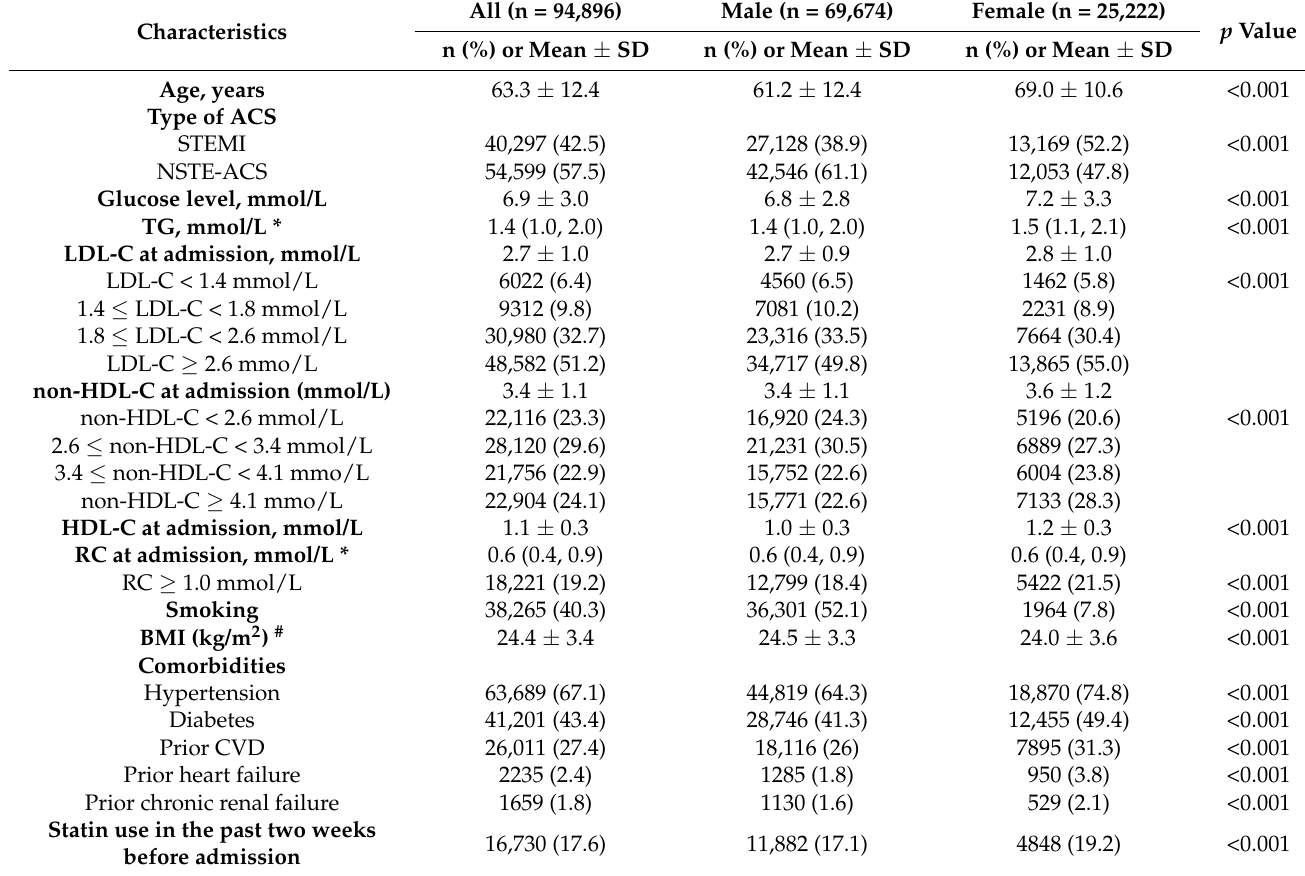
Table 1. Characteristics of patients hospitalized for acute coronary